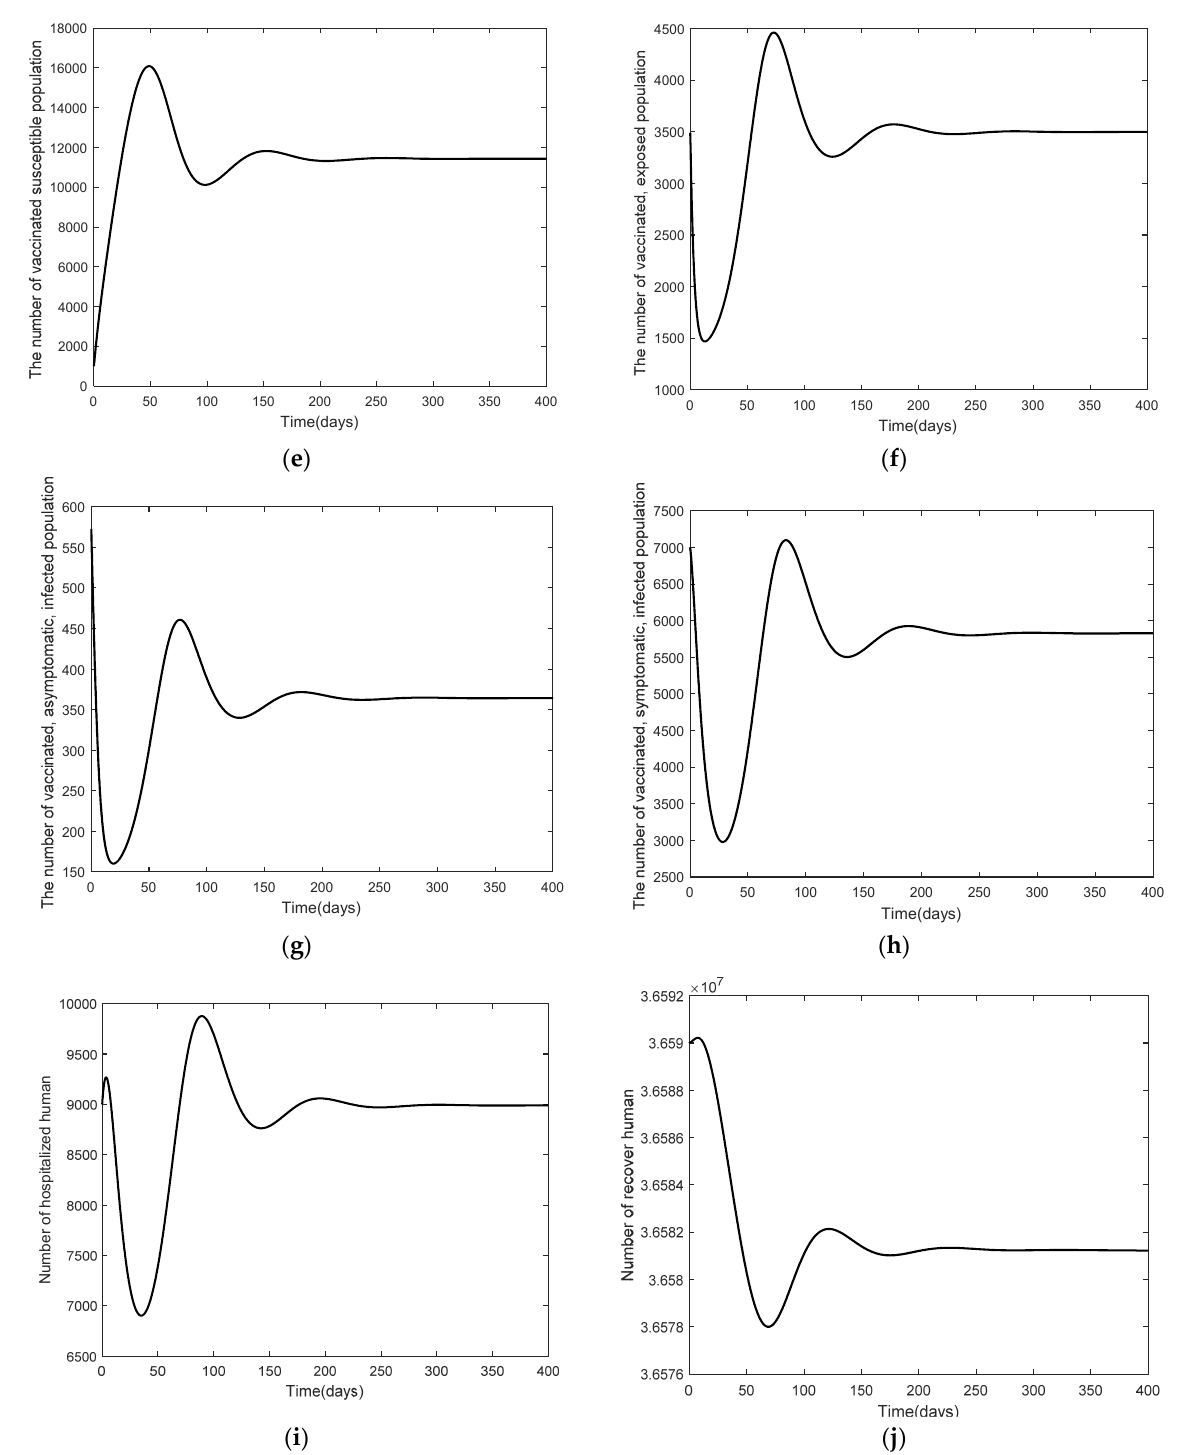
Figure 4. Graphs of the system Equations (3)–(12) at the endemic equilibrium point of S n , E n , I an , I sn , S v , E v , I av , I sv , H p , and R when R 0 > 1: ( a ) the number in the unvaccinated, susceptible population; ( b ) the number in the unvaccinated, exposed population; ( c ) the number in the unvaccinated, asymptomatic, infected population; ( d ) the number in the unvaccinated, symptomatic, infected population; ( e ) the number in the vaccinated susceptible population; ( f ) the number in the vaccinated, exposed population; ( g ) the number in the vaccinated, asymptomatic, infected population; ( h ) the number in the vaccinated, symptomatic, infected population; ( i ) the number in the hospitalized population; and ( j ) the number in the recovered population.